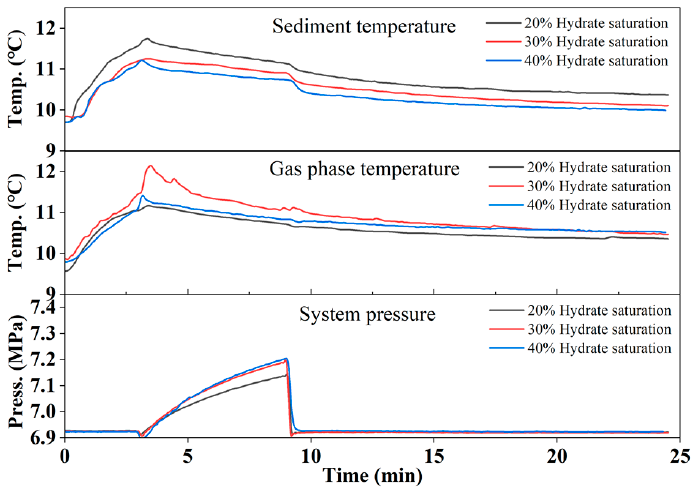
Figure 4. Temperature and pressure profiles of the sediments with different initial hydrate saturation. The effect of injected hot water temperature was investigated in Exp. 1, 6, and 7, where the hot water temperatures were 30, 40, and 50 ◦ C, respectively. It could be seen that the temperature rise in sediments increased by 1.3, 1.7, and 2.8 ◦ C, respectively, as seen in Figure 5; these increases were higher than simply increasing the volume of injected water. However, the pressure rise during the soaking step was not found to evidently enhance gas production, suggesting that the injected heat was not adsorbed by hydrates [41]. Although gas production was increased from 0.392 to 0.488 L, the thermal efficiency reduced from 37.3 to 23.6%.